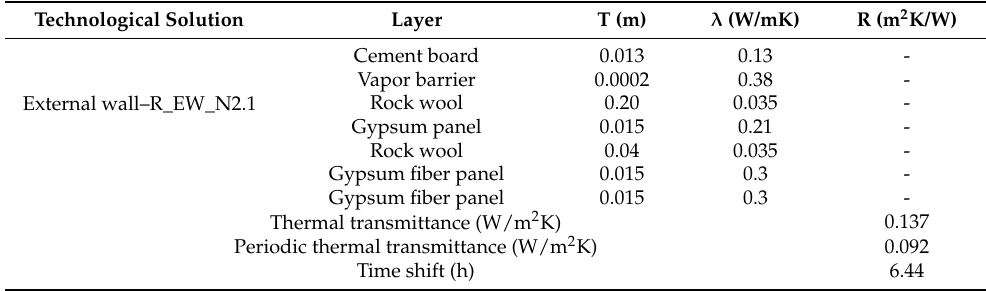
Table A23. Possible redevelopment measure for external wall with dry solution (rock wool insulation) characterized by the half value of the thermal transmittance of the reference building (R_EW_N2.1).